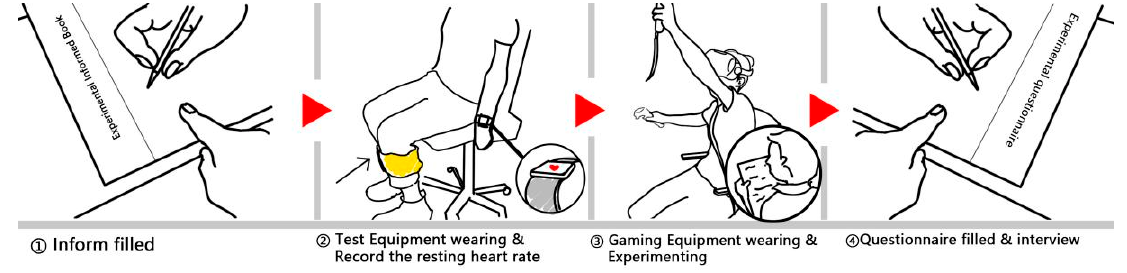
Figure 6. Experimental steps.